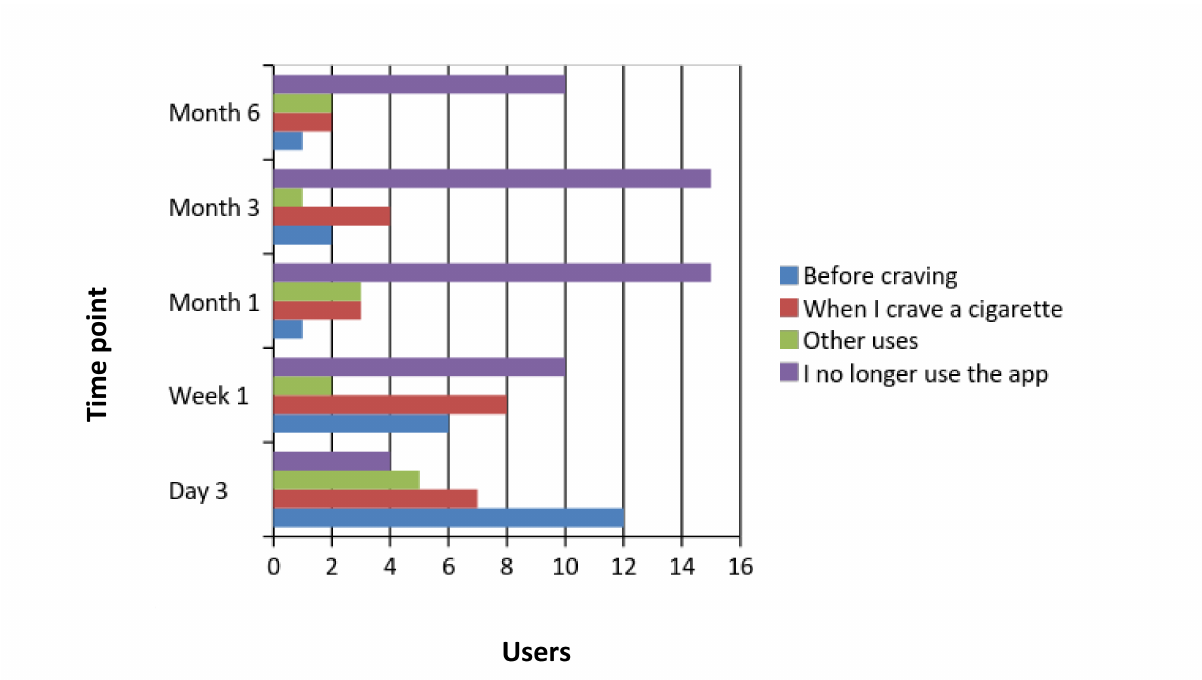
Figure 3. Fidelity responses of the intervention group detailing when, how, and why participants used the app.